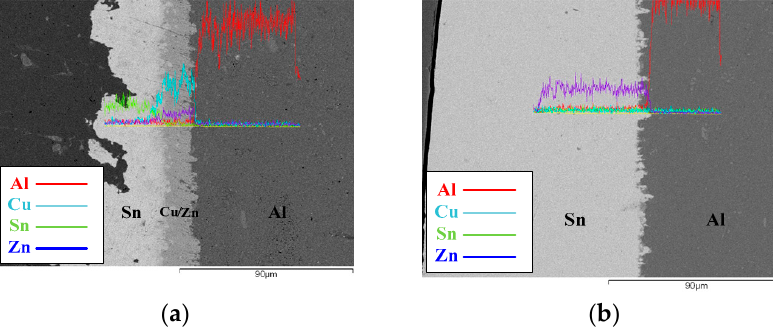
Figure 1. Interfacial images of ( a ) the electroplating (EP) and ( b ) the hot-dipping (HD) photovoltaic (PV) Al-ribbons.